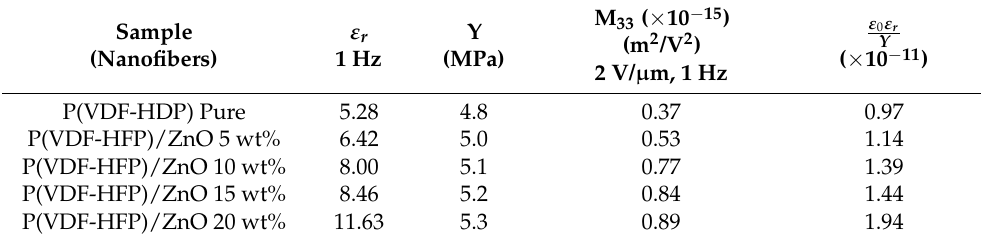
Table 2. Dielectric constant ( ε r ), Young’s modulus, and M 33 coefficient for the fabricated P(VDF- HFP)/ZnO composited